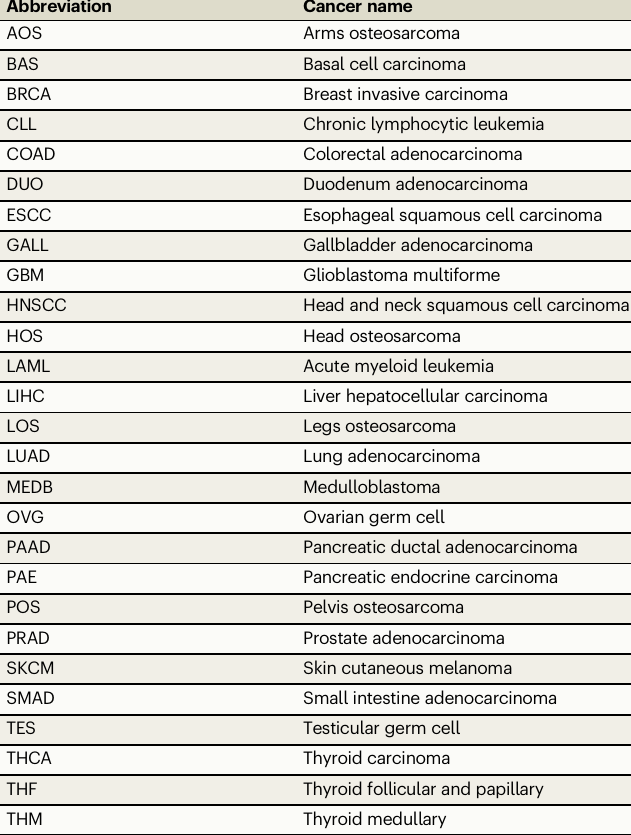
Table 2 | Abbreviations of cancer types (if applicable, following the TCGA study